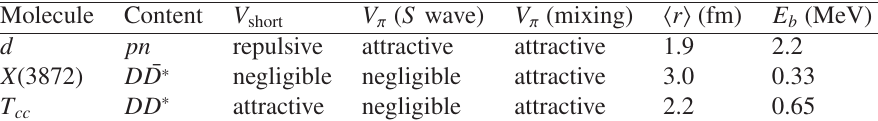
Table 1. Molecular structures obtained using Eq. (1)